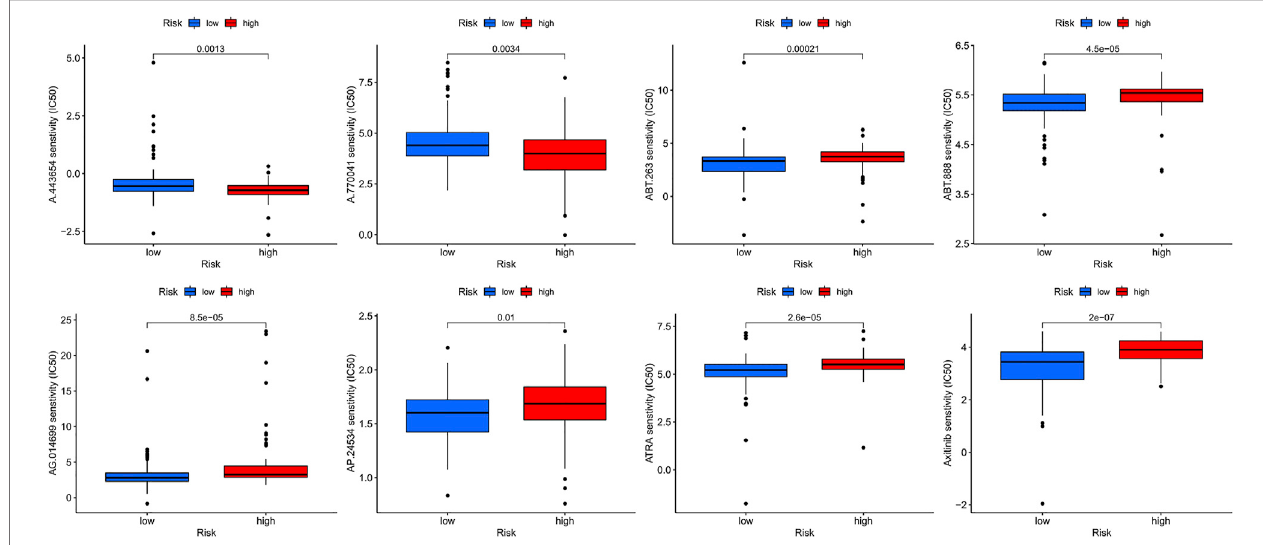
Frontiers in Genetics |